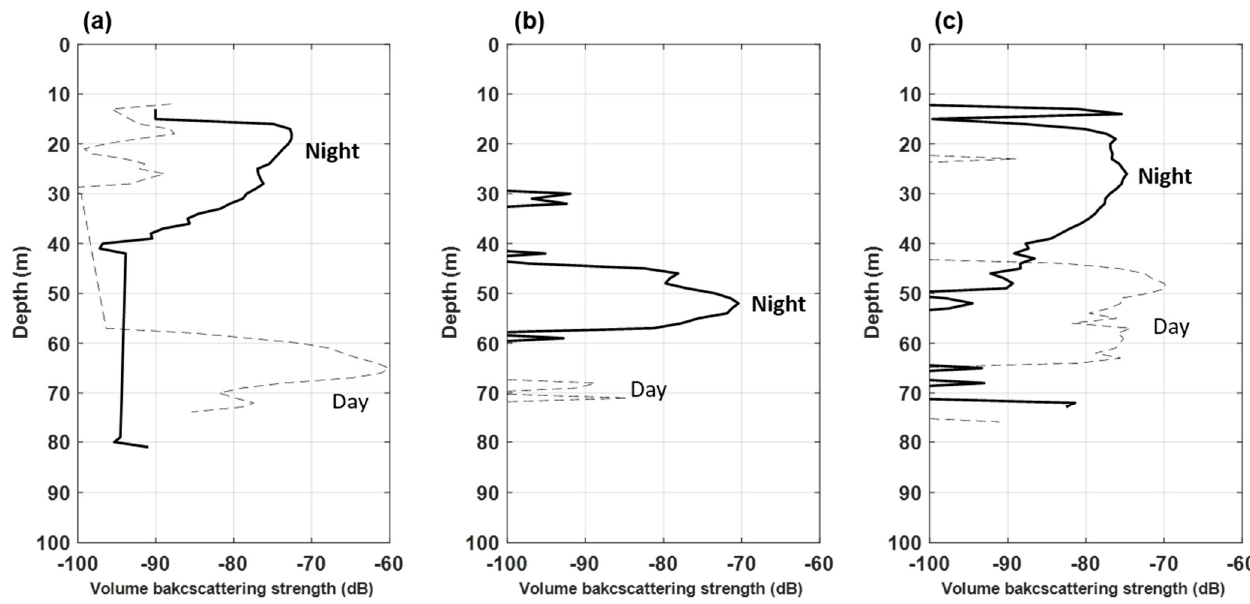
Figure 5. Variations in mean volume backscattering strength ( ∆ MVBS ) of the 200 kHz during day- time and nighttime in the YSBCW at ( a ) Transect 1, ( b ) Transect 2, and ( c ) Transect 3